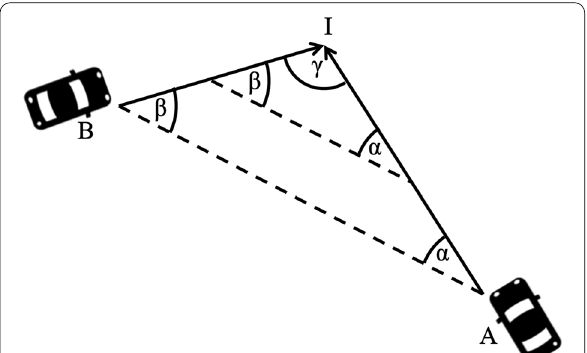
Fig. 6 Illustration of the CBDR principle. Two vehicles A and B are driving on straight paths that intersect at the point I, each with their own constant speed. If the bearing α of vehicle B viewed from vehicle A remains constant at all times, the vehicles are going to reach the intersection I simultaneously, i.e. they are going to collide. Note that, by symmetry, this also means that the bearing β of vehicle A is constant. If the bearing α decreases with time, vehicle B will have passed the intersection when vehicle reaches it (this is only true in a strict sense if we neglect the size of the vehicles). Conversely, if α increases, vehicle B will not yet have reached the intersection. Note that these rules are valid irrespective of the angle γ between the straight